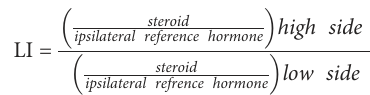
pathways, conversion ratios based on adrenal size and radiological asymmetry were calculated with adrenal vein metabolite/its precursor, and conversion ratios based on ARMC5 status calculated with peripheral metabolite/its precursor, accordingly (19,